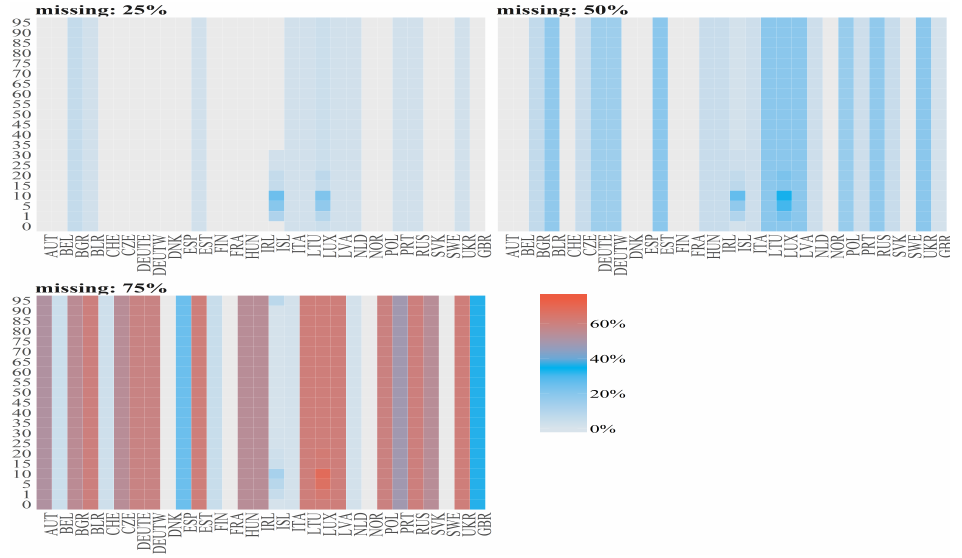
Figure 5. Percentages of missing values (denoted by diffrent colours) for Number of Deaths for Females per country (x axis) and age group (y axis). The titles of the subplots indicate the case of missing values (25%, 50%, 75%). The percentage of missing values for a given country and an age group is calculated dividing number of missing values by length of subsample which is different for different